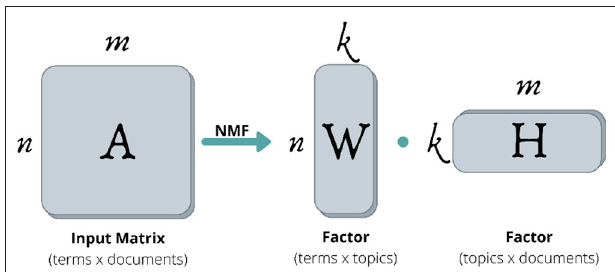
FIGURE 2 | Intuition of NMF. Source: Egger